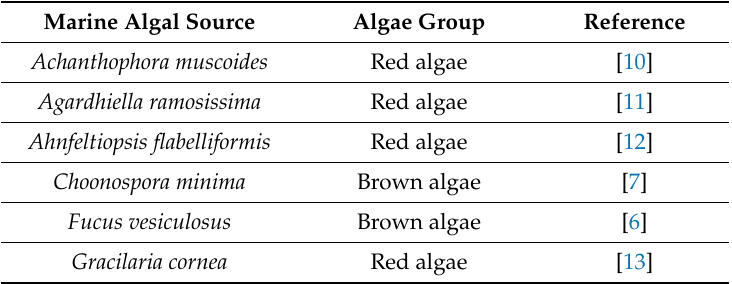
Table 1. Marine algae source with anti-inflammatory activity attributed to sulfated polysaccharides